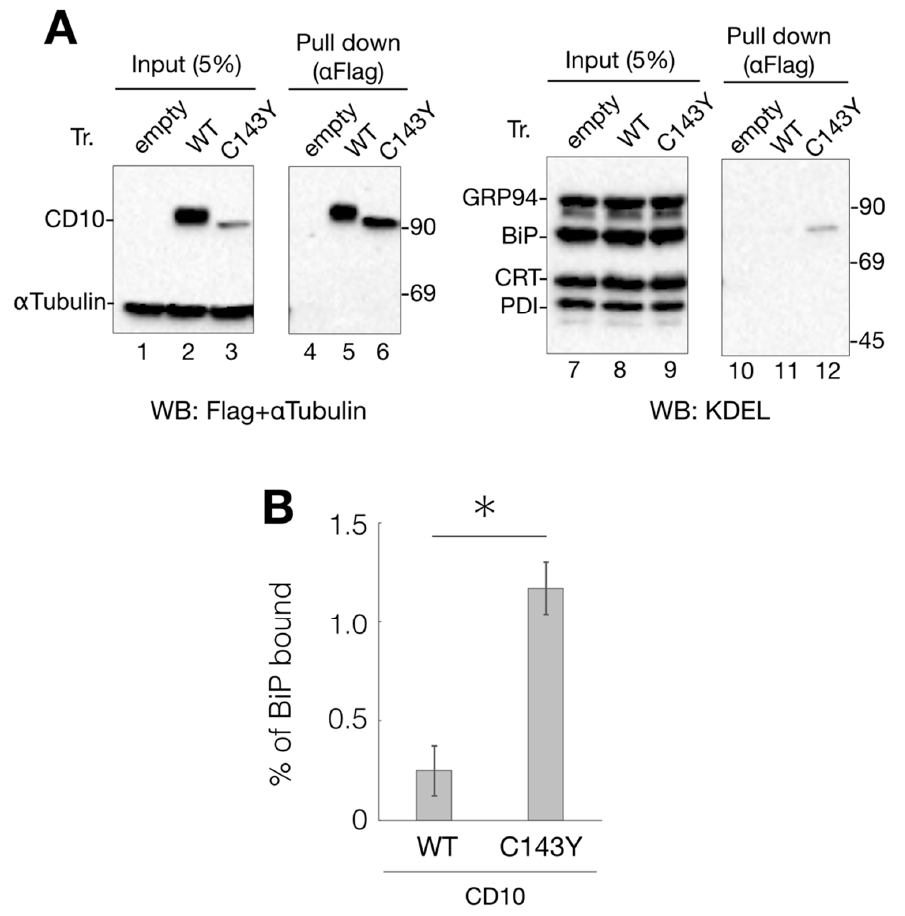
Figure 3. Interaction of CD10 C143Y with ER chaperone BiP. ( A ) association of BiP with CD10 C143Y. Flag-tagged WT CD10 and C143Y expressed in HeLa cells were extracted with 1% NP-40-containing buffer. Lysate (5%) was loaded as the input (lanes 1–3 and 7–9, respectively). WT CD10 and C143Y-Flag were immunoisolated using anti-Flag agarose beads and eluted with Flag peptide (lane 4–6 and